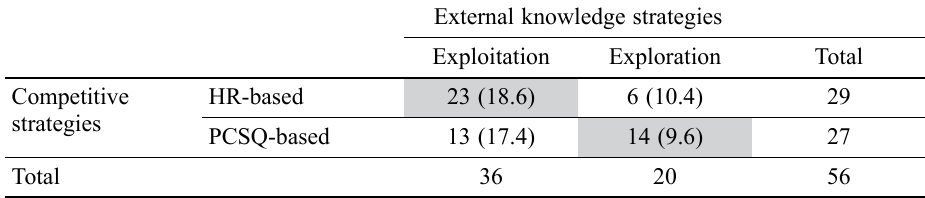
Table 3. Cross-tabulation between external knowledge strategy groups